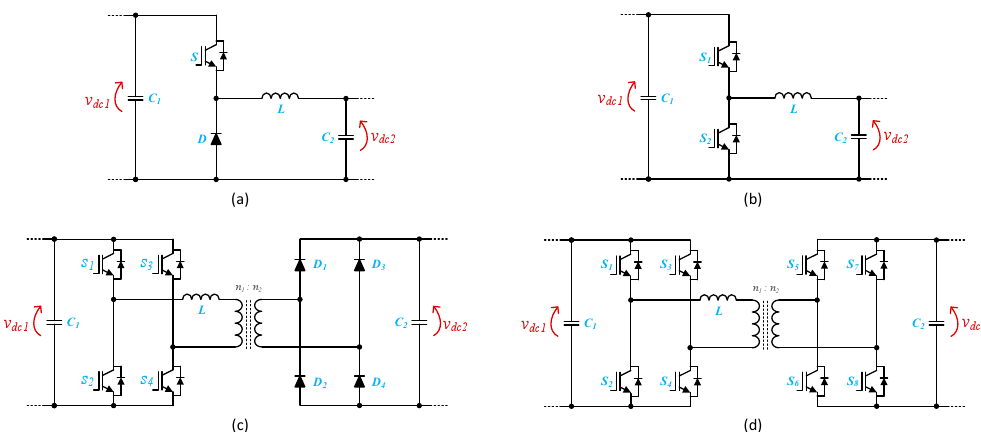
Figure 4. Main power electronics converters used as back-end power stage of on-board EVBC: ( a ) unidirectional buck-type; ( b ) bidirectional half-bridge; ( c ) unidirectional isolated; ( d ) bidirectional isolated (dual active bridge).